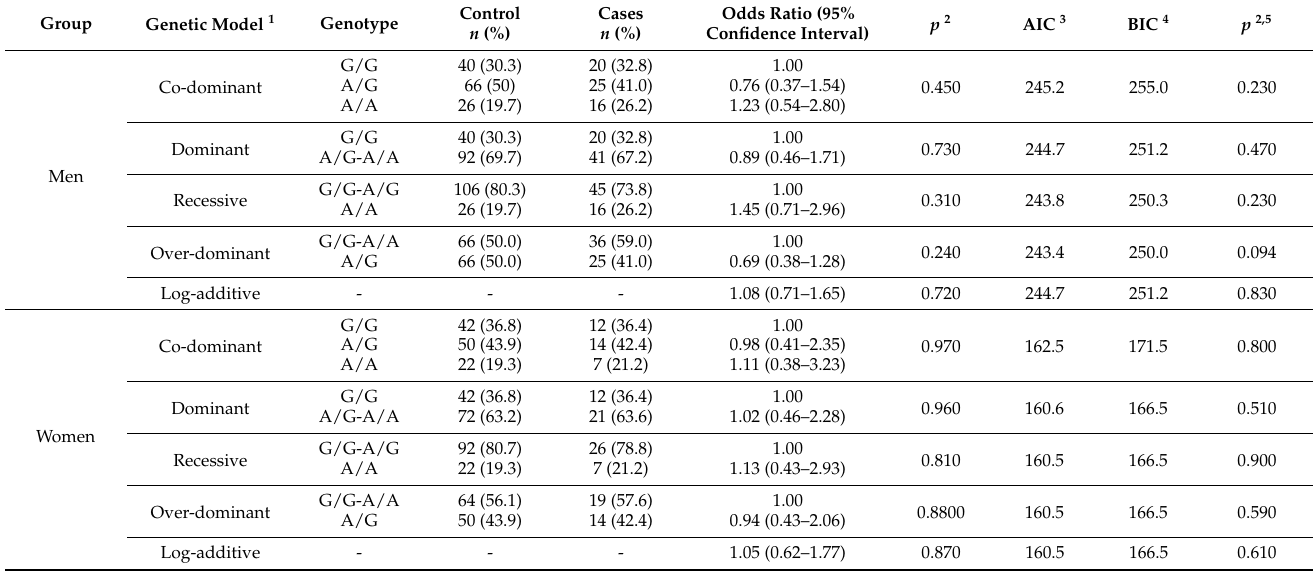
Table 4. Sex-stratified association analysis of polymorphism rs10719 in DROSHA with pseudoexfolia- tion glaucoma